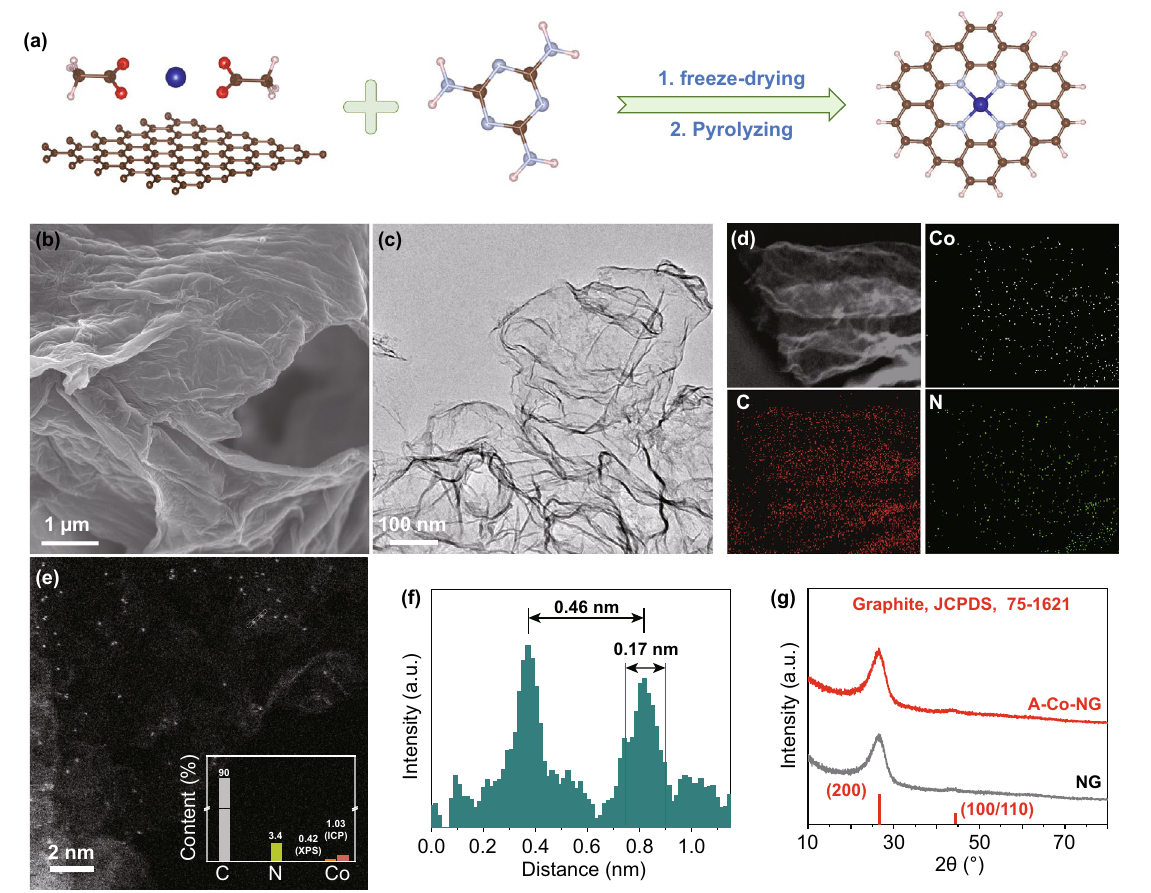
Fig. 1 a Schematic illustration of the synthetic procedure of the A–Co–NG nanozyme. Structural characterization of A–Co–NG: b SEM image; c Bright-field TEM image; d EDX mapping images; e HAADF-STEM image, inset is content of atoms; f Statistic distance between adjacent Co bright spots; g XRD diffraction patterns of A–Co–NG and